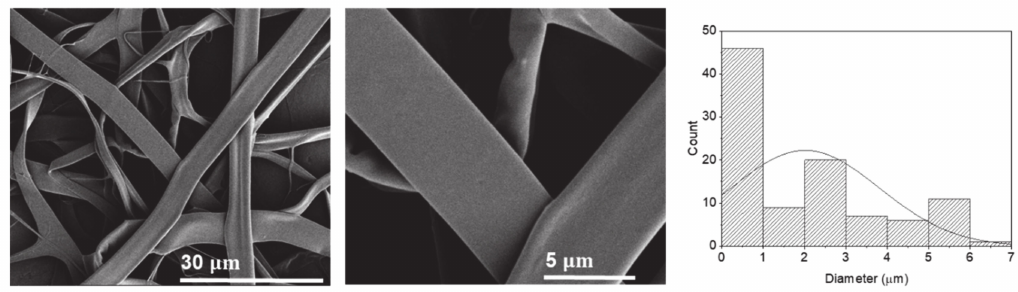
Figure 6. SEM images of electrospun potato protein fibers loaded with 0.05% w / v vitamin B12 and respective histogram displaying their diameter